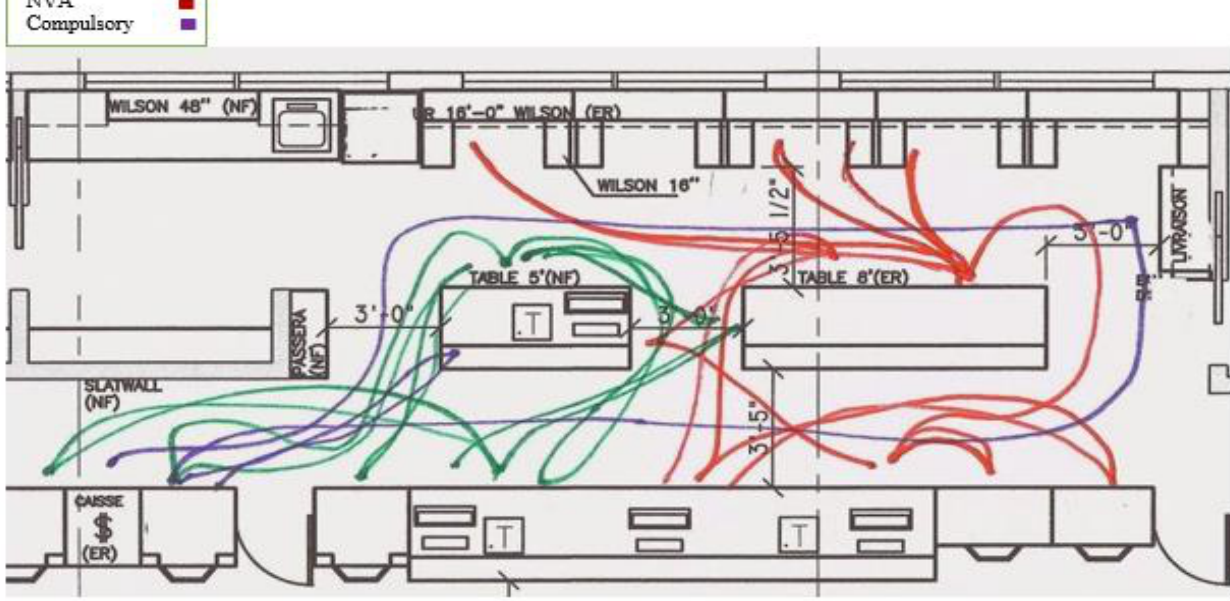
Figure 8. The Spaghetti diagram for visualized workstation movement, material handling, and parts storage (VA – value added times; NVA – Non-value-added times; Compulsory – operations). storage (VA—value added times; NVA—Non-value-added times;